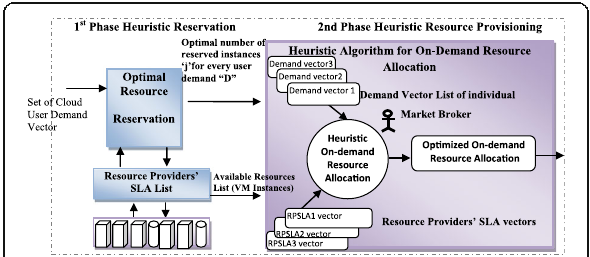
Fig. 3 Two-Phase Coordinated Resource Reservation and Provisioning (CRRP) Model